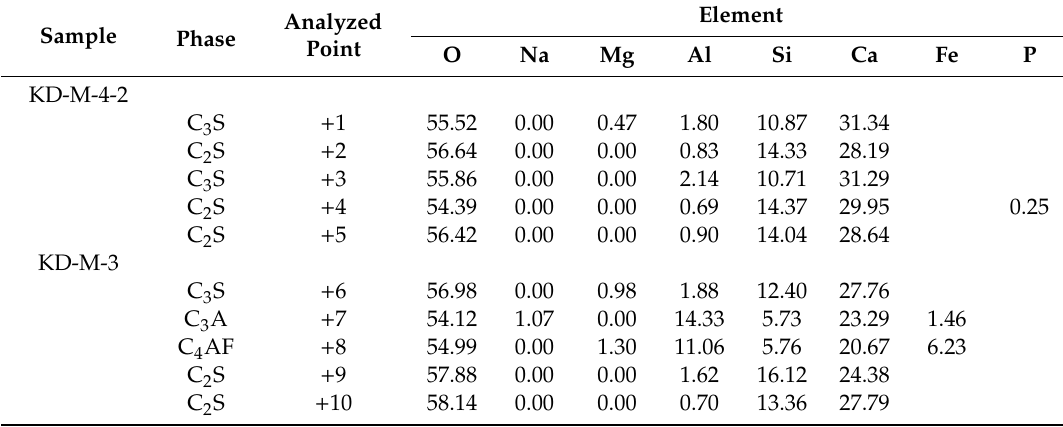
Figure 3. SEM elemental maps and backscattered (BSE) electron image showing the qualitative chemical composition of the cement render with residual cement grains from sample KD-M-4-2. Table 1. Chemical composition, in atomic percentage, of characteristic residual cement grains. For exact position of the analyzed points, see Figure 4 for the sample KD-M-4-2 and Figure 10 for the sample KD-M-3, discussed in the paragraph 3.2.